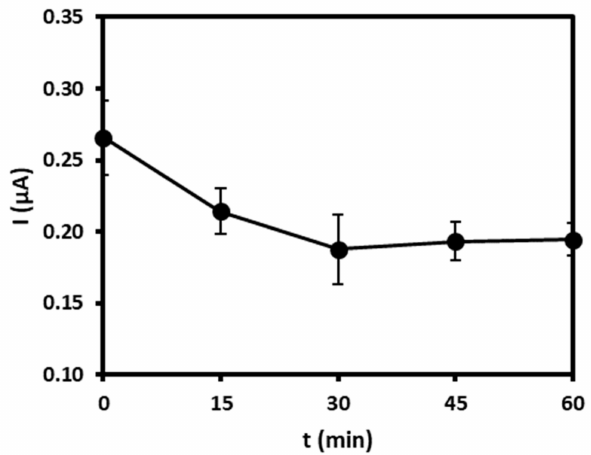
Figure 3. Optimization of the incubation time (15, 30, 45, 60 min) of LDL solution of 0.5 mg/mL on AbM-anti-apoB-Fc-modified gold electrodes registered using square wave voltammograms in buffer (pH =